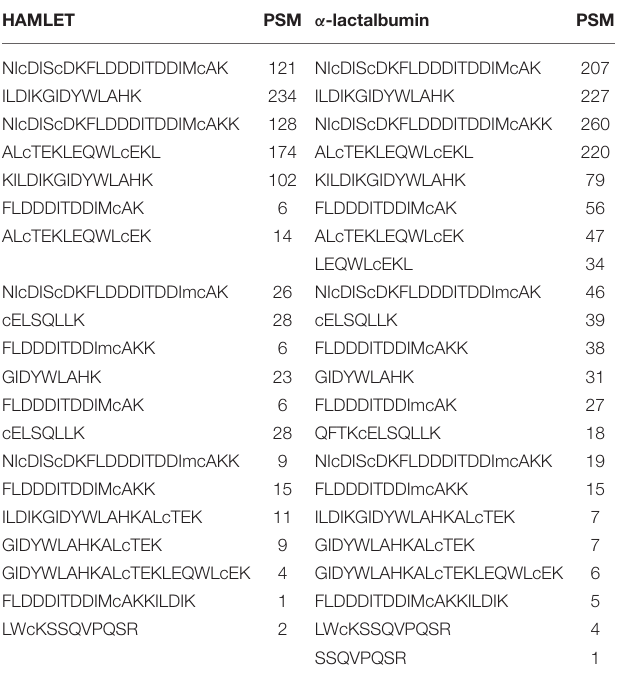
a 96-day-old sample of human milk (confirmed first by MTT) was diluted to 1% concentrations and incubated for 2 h with FHs 74 grown on slides and TUNEL stained ( Figure 7 ). Apoptosis, rather than lysis, was demonstrated. Non-cytotoxic human milk (confirmed by MTT) was used as a comparison, and it did not promote